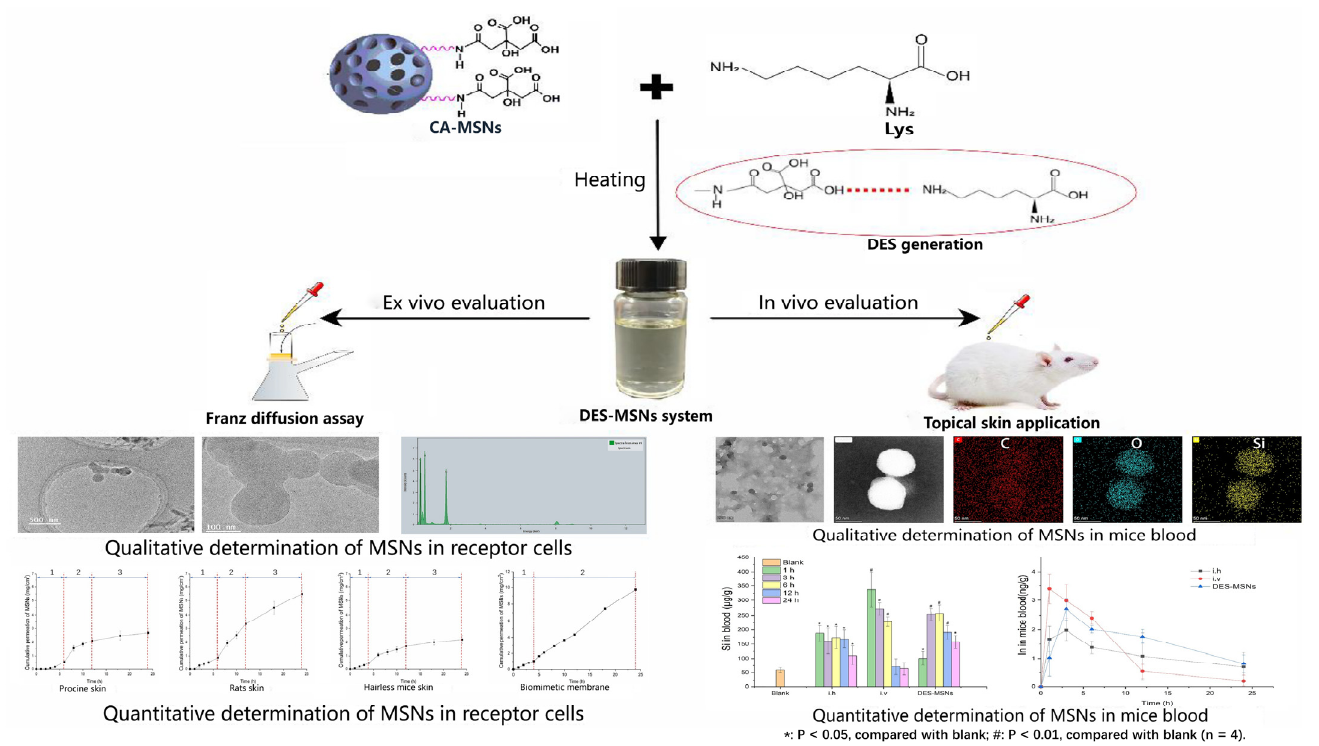
Figure 1. Skin drag effect and permeation-promoting mechanism of the eutectic system on rigid mesoporous silica nanoparticles.